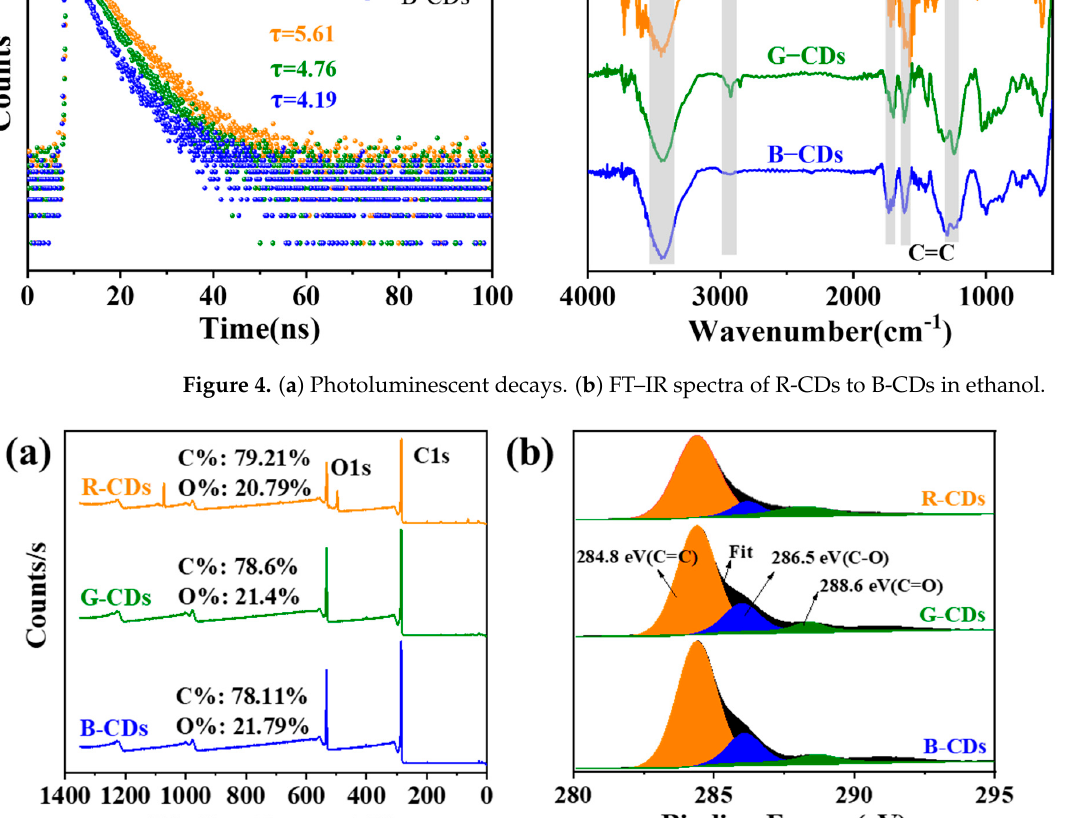
Figure 5. ( a ) XPS surface spectra and ( b ) high-resolution C1s spectra for R-CDs, G-CDs, and B-CDs.